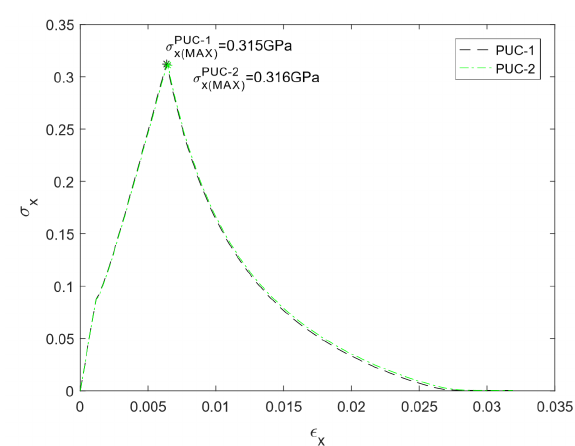
Figure 8. Stress-strain curves for on-axis compressive loading in the x-direction.